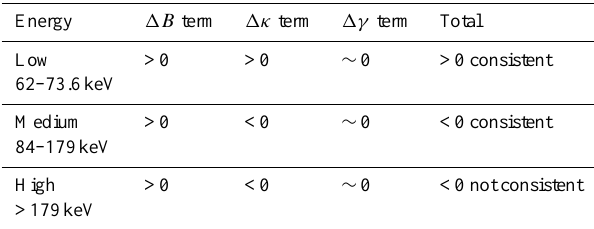
Table 2. Response of the three terms to a transient compression for the pulsation examined in Fig